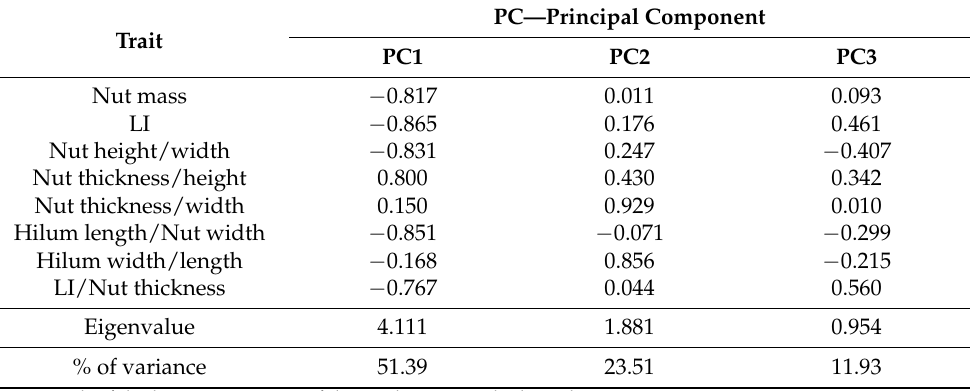
LI—Length of the longest intrusion of the seed coat into the